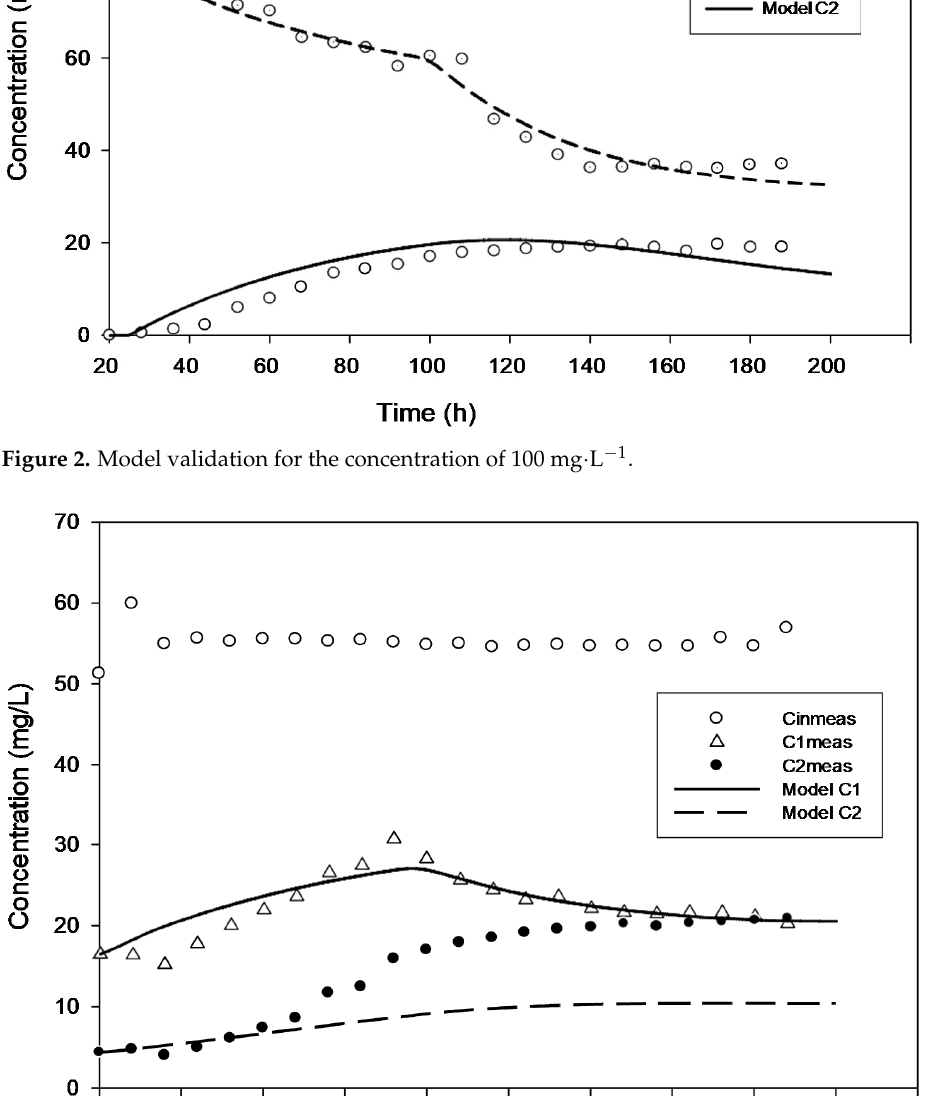
Figure 3. Model validation for the concentration of 50 mg · L − 1 with added H 2 O 2.